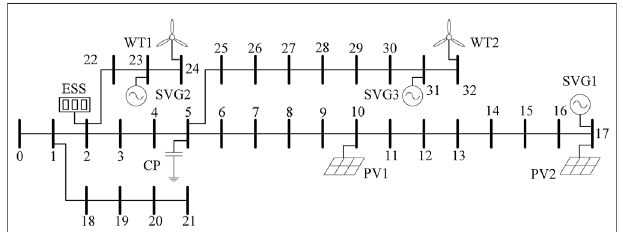
FIGURE 7 | A 33-bus radial active distributed network.